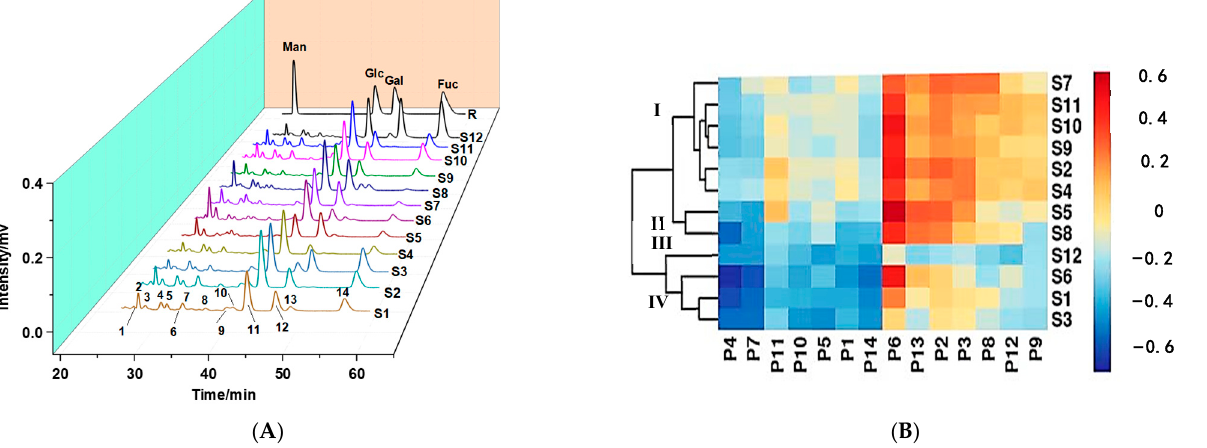
Figure 4. Partial acid hydrolysates of Ganoderma lucidum polysaccharides. PMP–HPLC fingerprint ( A ), hierarchical cluster analysis of PMP–HPLC fi ngerprint ( B ). R: standards pro fi le.